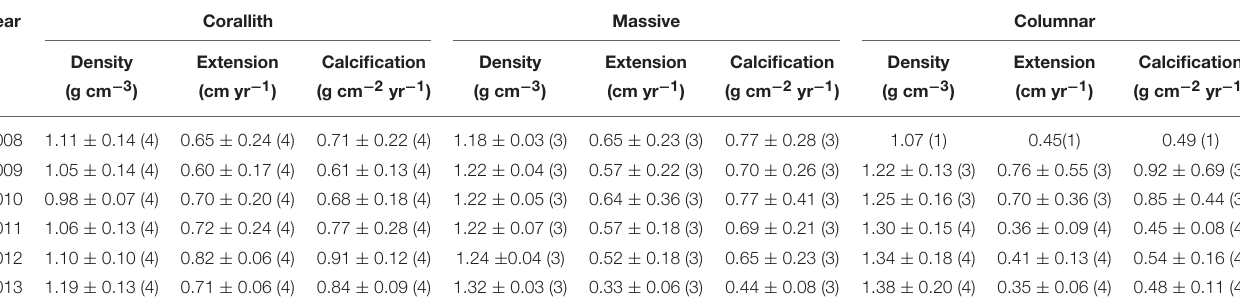
TABLE 1 | Mean annual growth ( ± SD) of P. lobata morphotypes: extension rate, skeletal density, and calcification rate, (n) indicate the number of pair of growth bands evaluated by